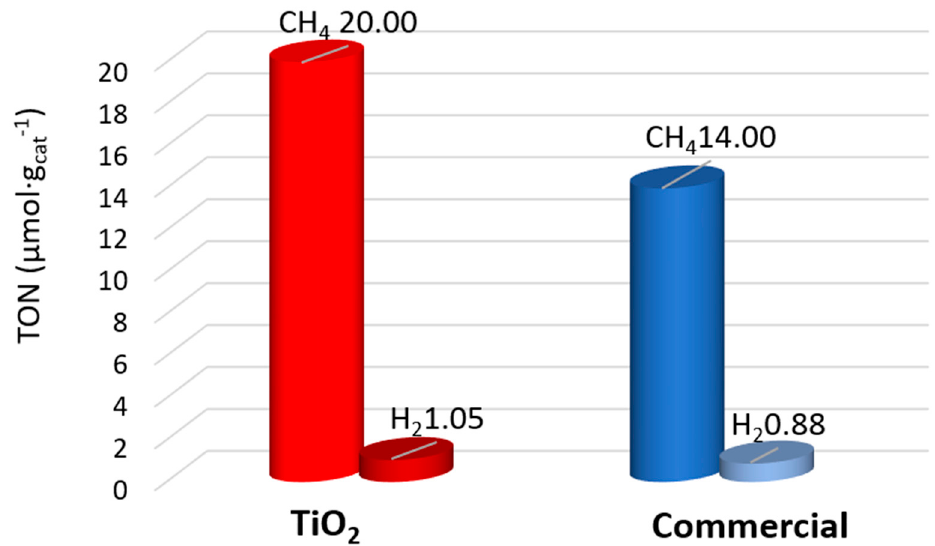
Figure 3. Photoactivity tests in the CO 2 photoreduction performed on unpromoted TiO 2 (red columns) and commercial titania (blue columns).